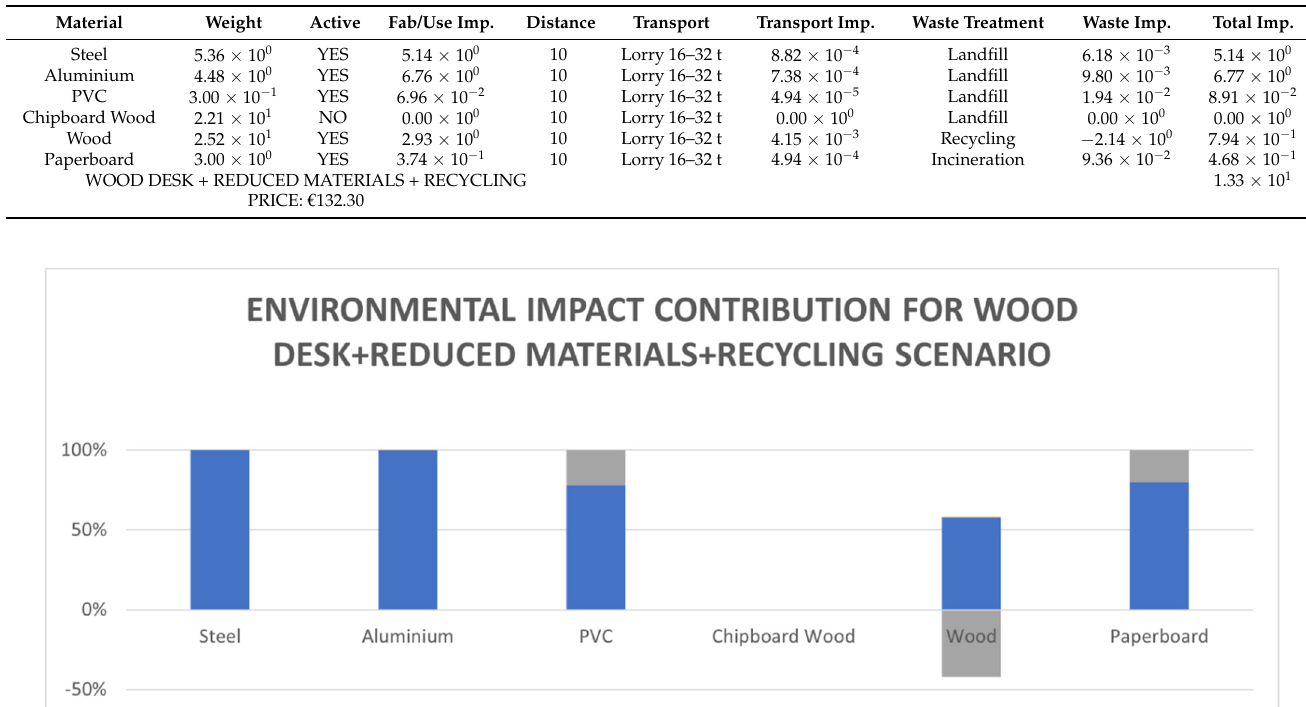
a narrower central area. Table 12. Results of chipboard wood desk + reduced materials + recycling scenario.